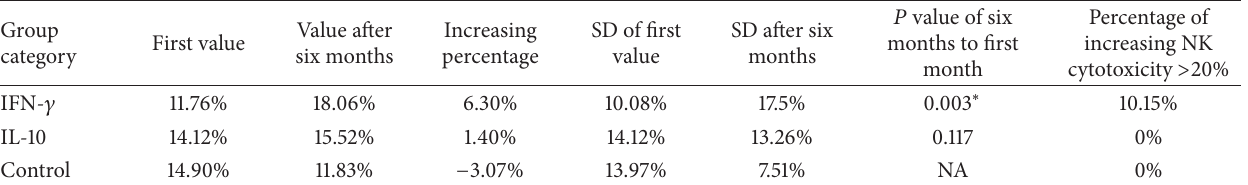
Table 2: The comparison of three groups between the first NK activity assessment and after six months. The asterisk symbol denotes the significant difference by Wilcoxon signed rank test.